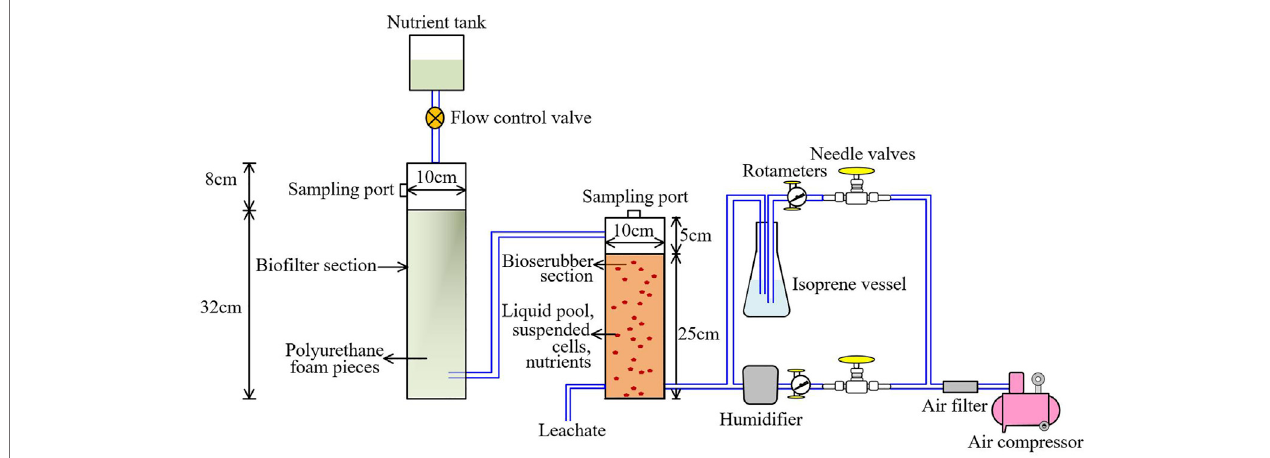
FIGURE 3 | The schematic diagram of bioreactor set-up.